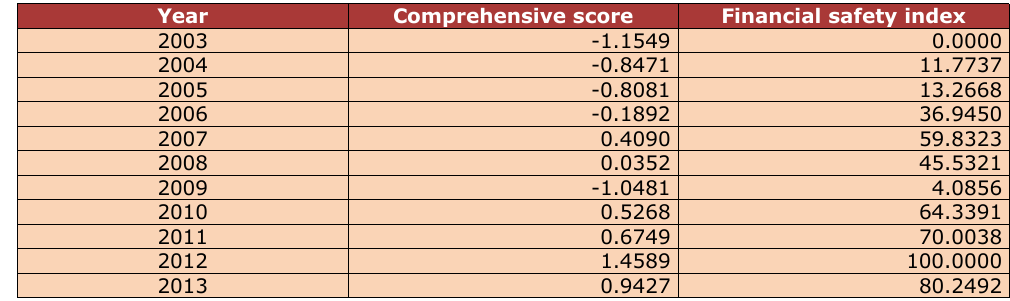
Table 6. Principal Component Analysis Comprehensive Score and Financial Safety Indexes